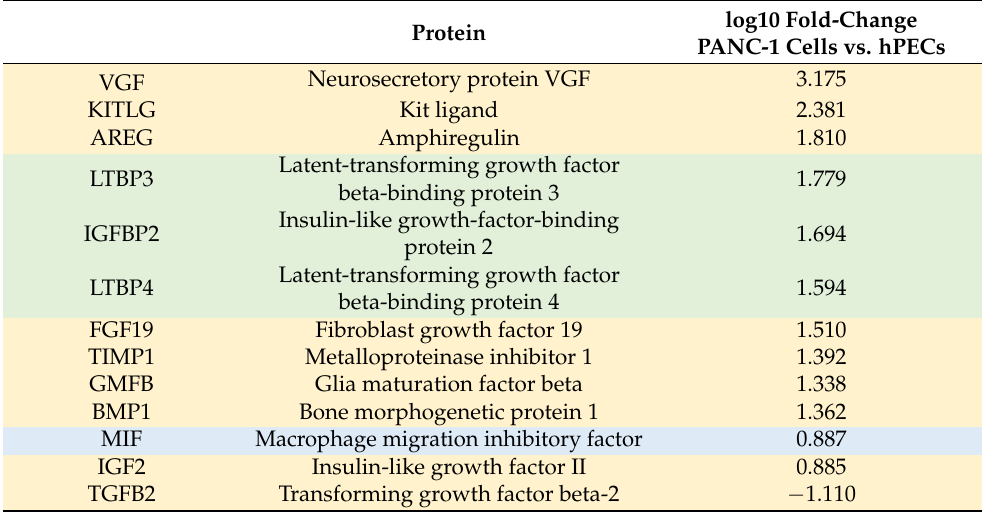
Table 1. Cytokines, growth factors, and growth-factor-binding proteins differently secreted by PANC-1 cells and